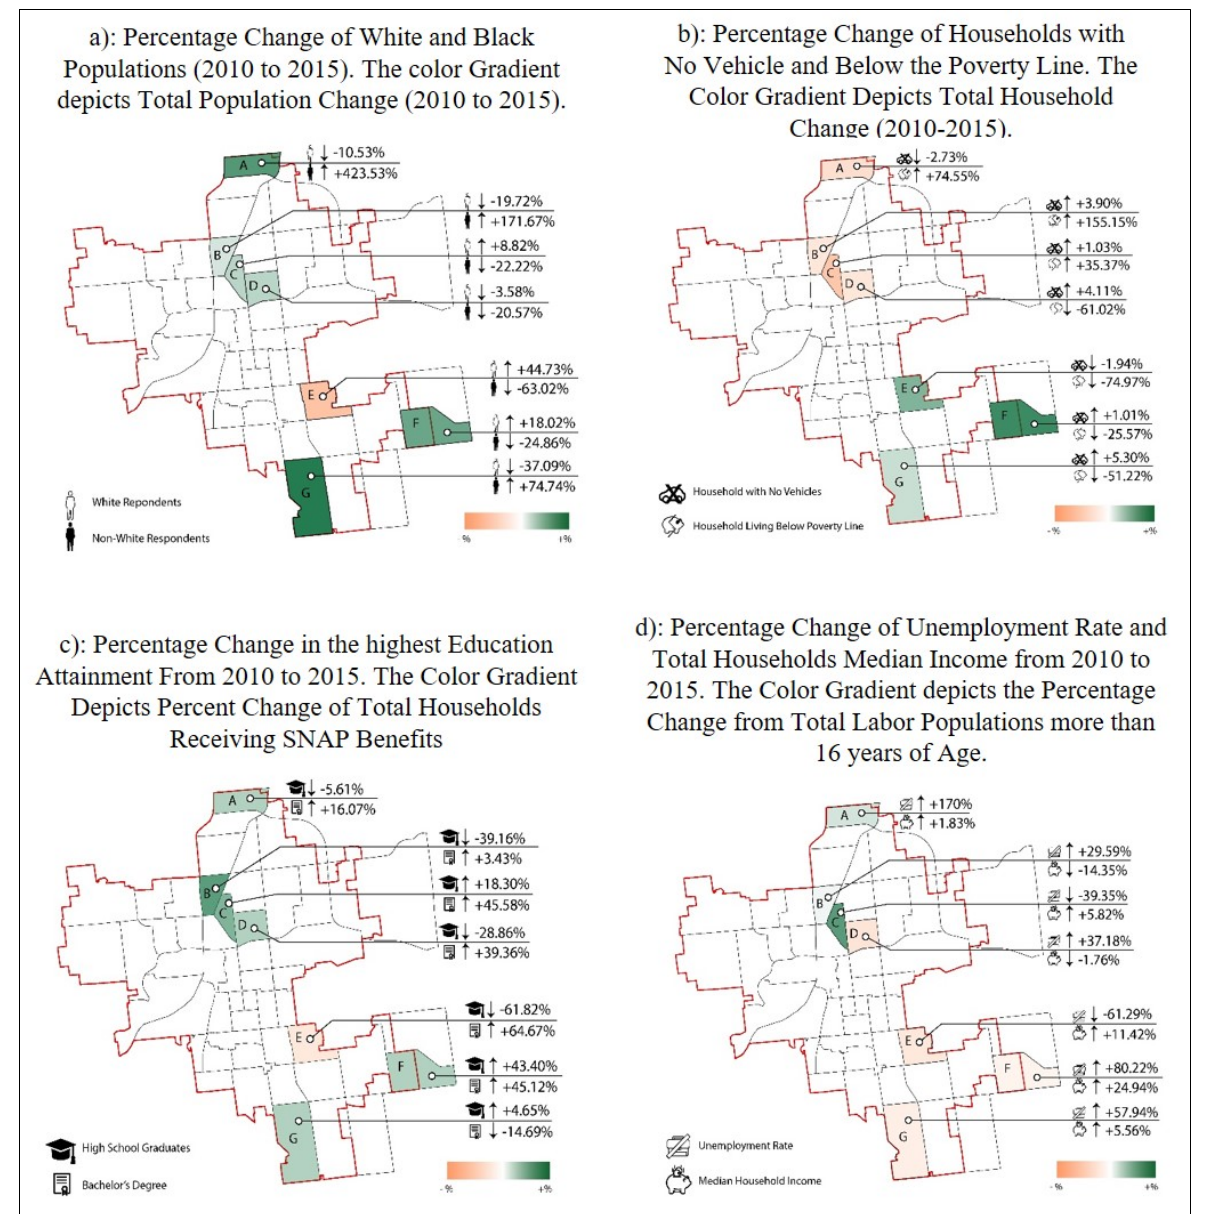
Figure 3. Change in Socio-demographic Characteristics from 2010 to 2015*